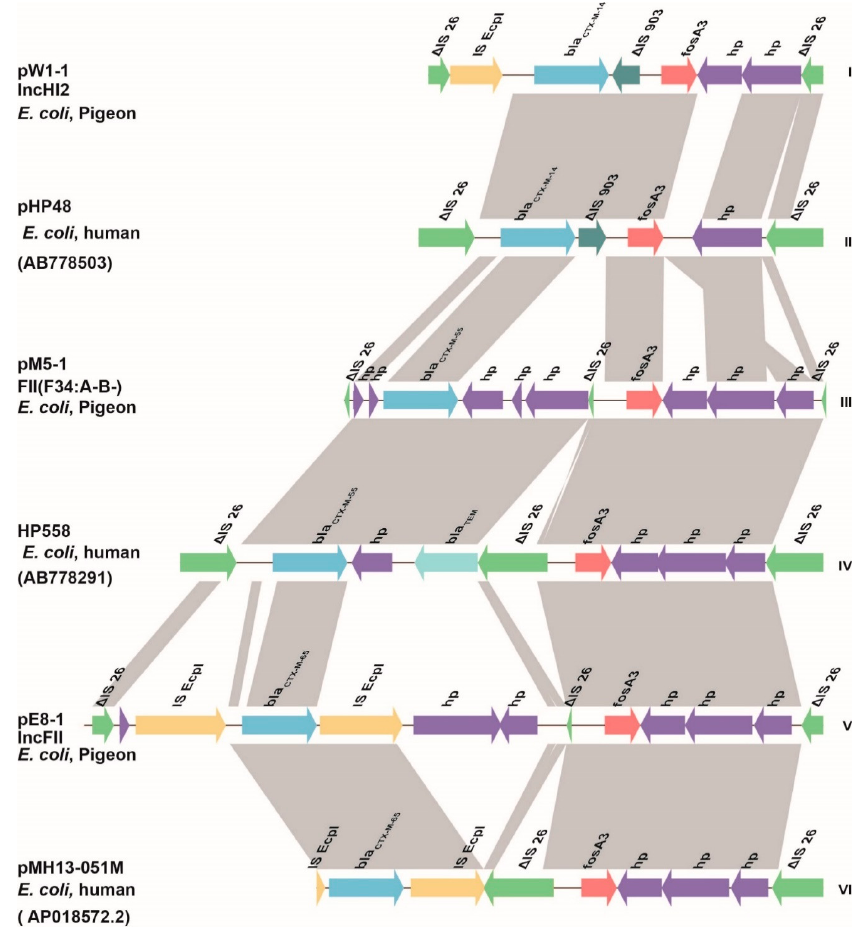
Figure 3. Genetic environment of fosA3 in 14 E. coli isolates. Arrows indicate the directions of transcription of the genes, and different genes are shown in different colours. Regions of >99.0% nucleotide sequence identity are shaded in grey. The delta ( ∆ ) symbol indicates a truncated